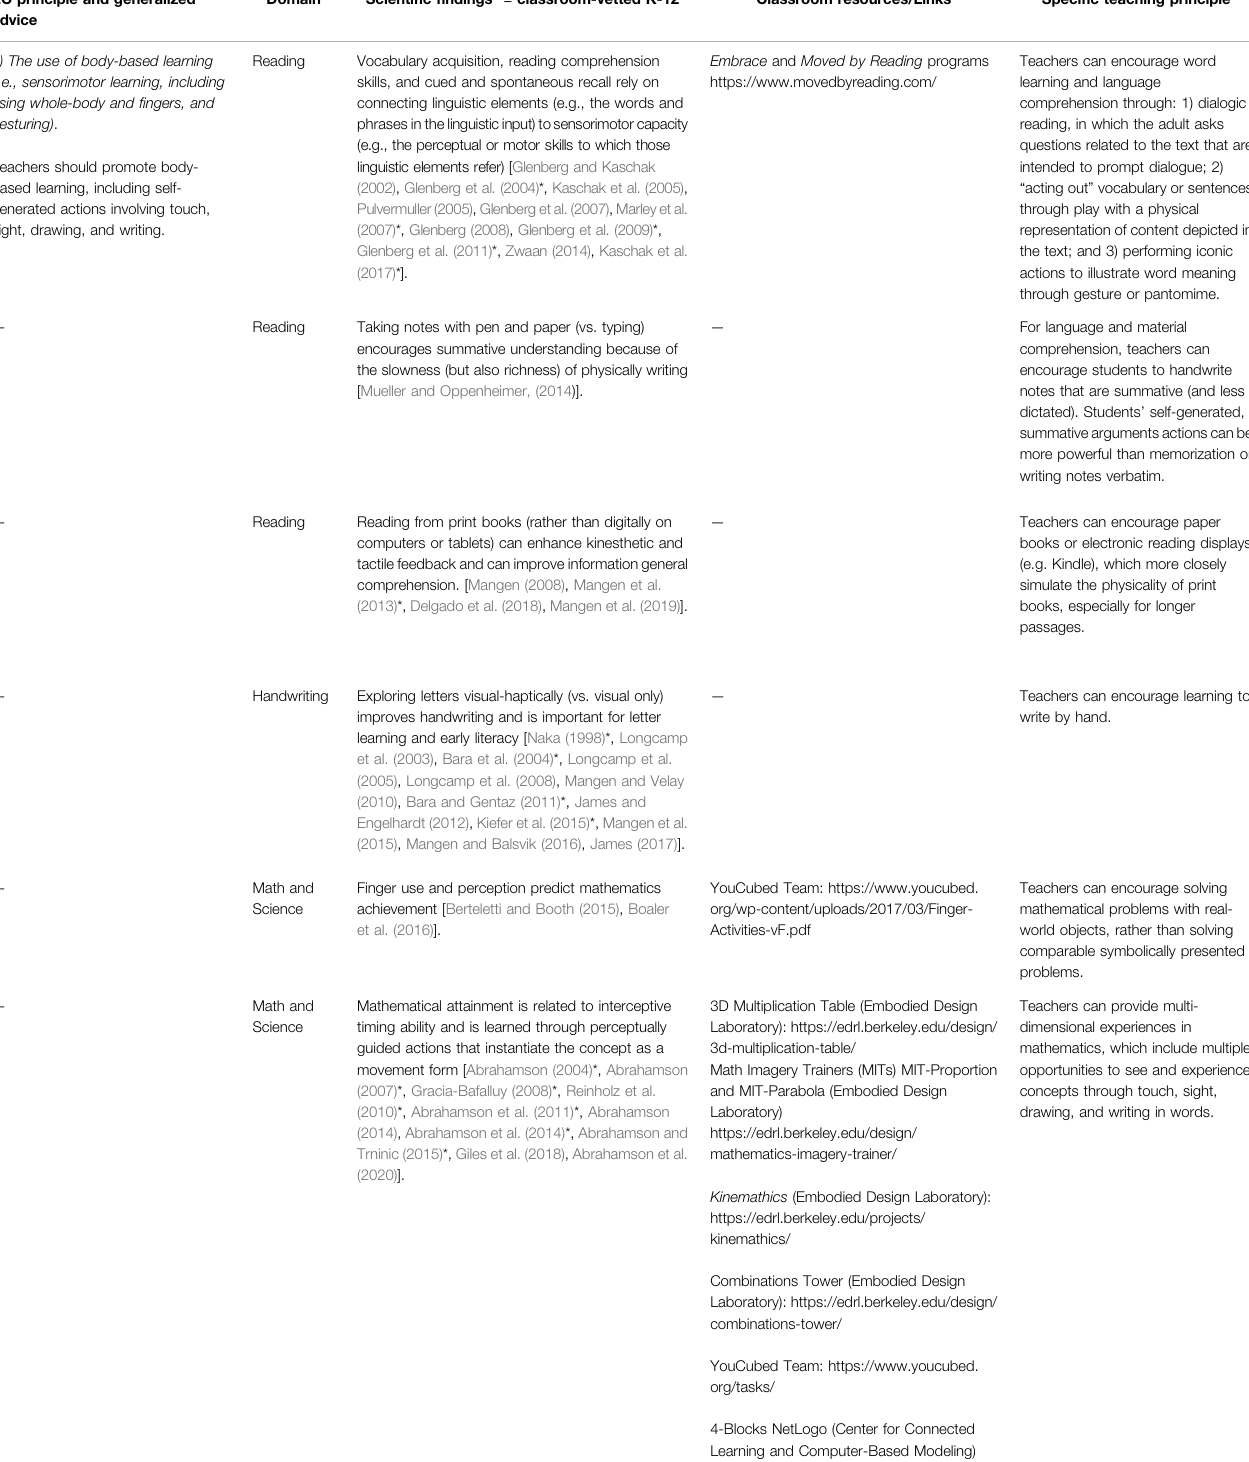
TABLE 1 | Key Principles for Translational Learning Sciences Research for Embodied Cognition and Embodied Learning. EC principle and generalized